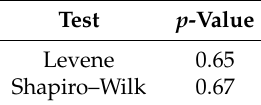
Table 11. Test to ensure the homoscedasticity and normal distribution of the evaluation results for the fine-grained